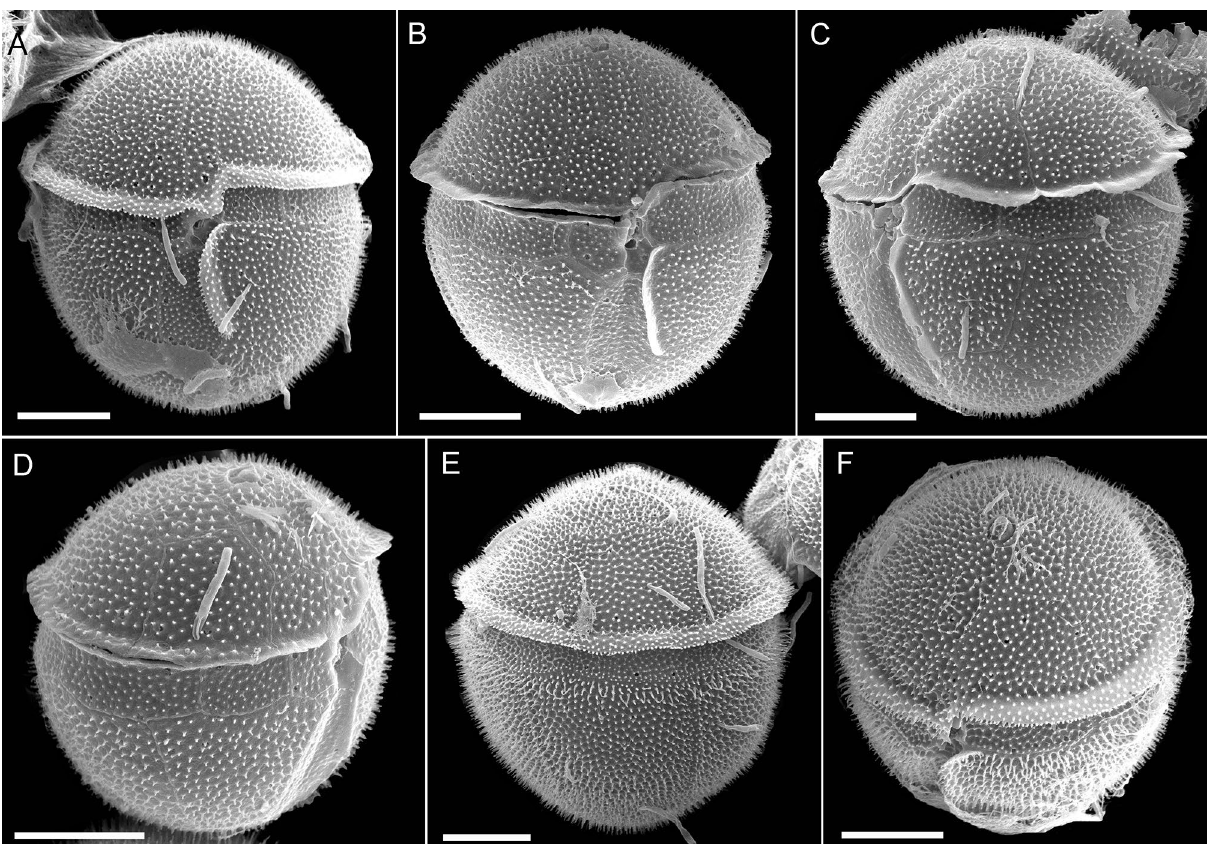
Figure 2. Scanning electron micrographs of Fensomea setacea , gen. & sp. nov . (GeoB*184) in ( A , B ) ventral view, ( C ) left lateral view, ( D ) right lateral view, ( E ) dorsal view, and ( F ) ventral apical view. Scale bars = 5